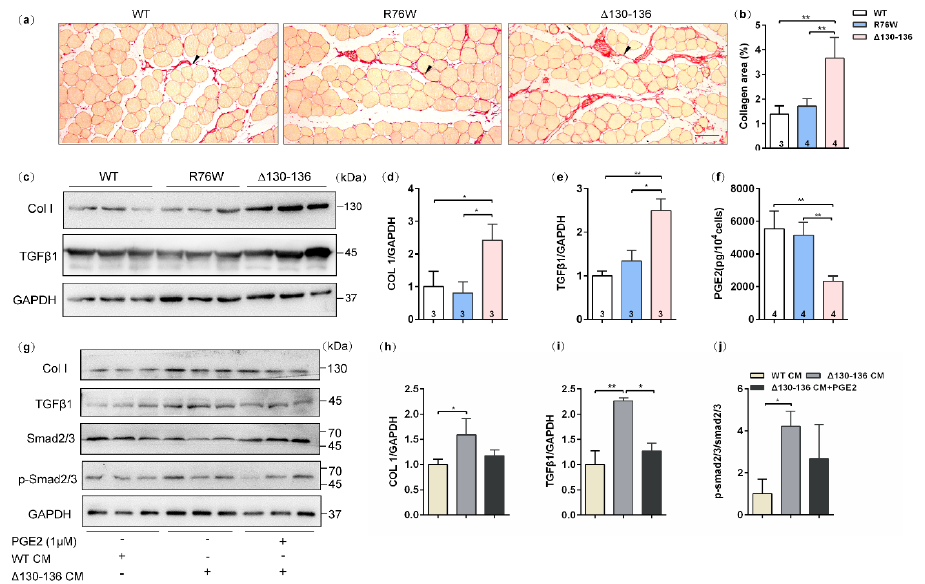
Figure 6. Increased muscle fibrotic phenotype in 18-month-old ∆ 130–136 mice and exogenous PGE 2 partially prevented collagen deposition. ( a ) Representative Sirius staining images of SL muscles